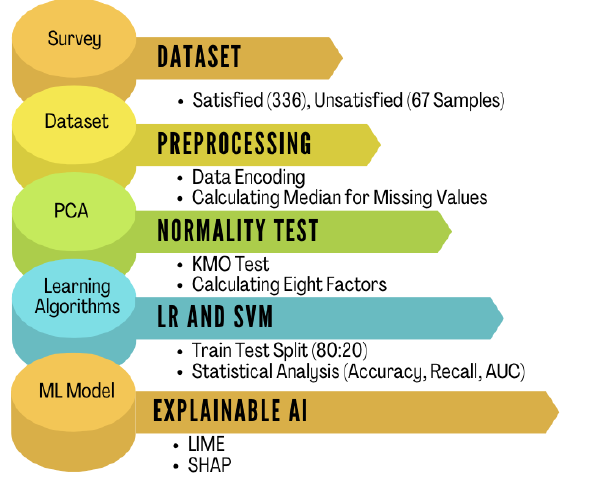
Figure 1. Conceptual